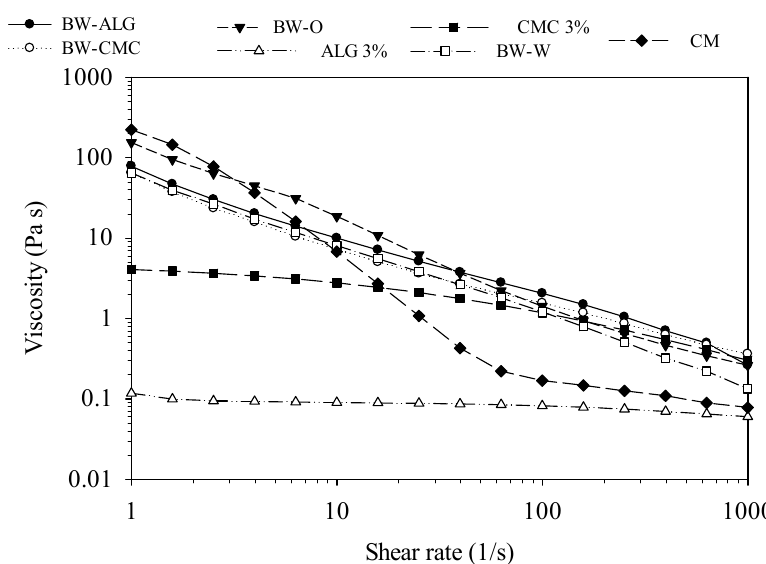
Figure 3. Viscosity as a function of shear rate of bigels (BW-ALG and BW-CMC), oleogel (BW-O), sodium alginate hydrogel (ALG 3%), carboxymethylcellulose hydrogel (CMC 3%), emulsion of BW-O with distilled water (BW-W), and commercial margarine (CM).